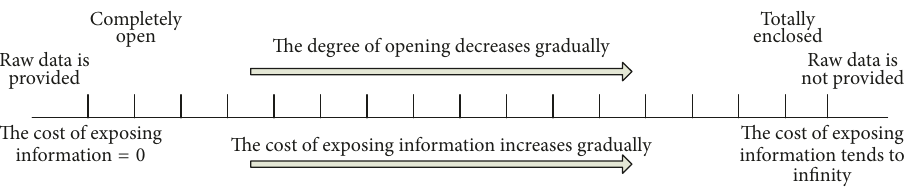
Figure 1: The relationship between OP (𝑑) and COST